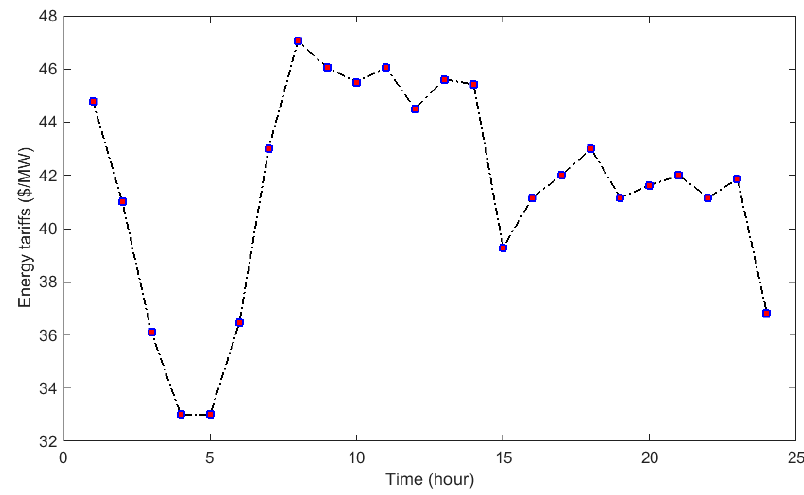
Figure 3. Hourly variations of energy rates.